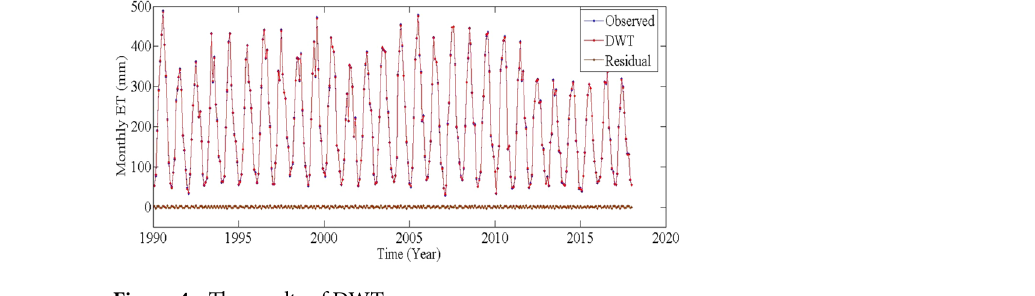
Figure 4. The results of